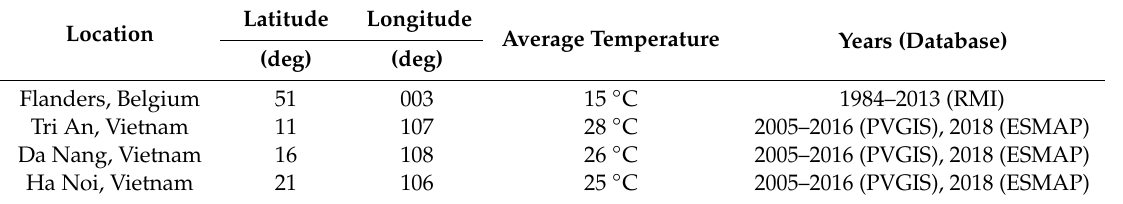
Table 1. Database resources for studied